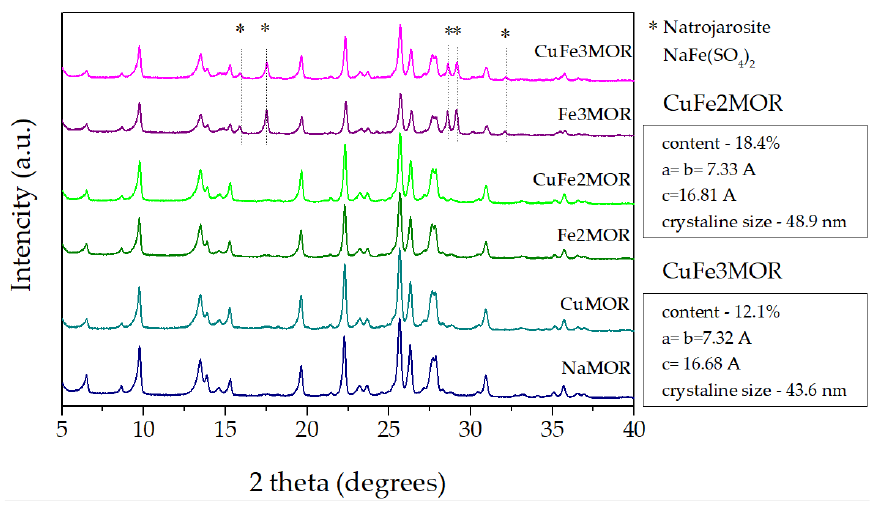
Figure 1. Powder XRD patterns for the studied samples. Stars indicate diffraction peaks correspond- ing to Natrojarosite.